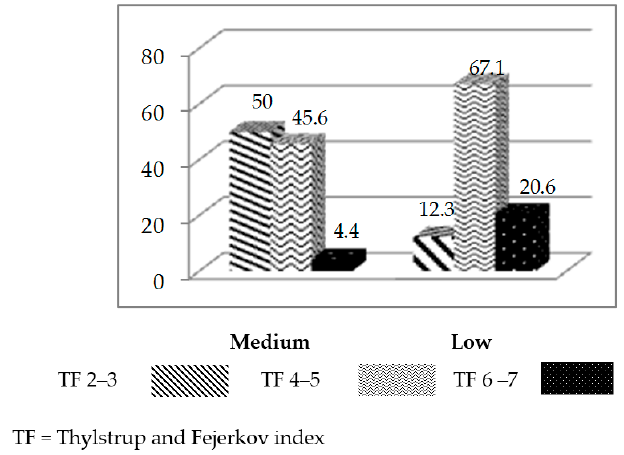
Figure 2. Severity of dental fluorosis in adolescents with medium and low SES in percentages.